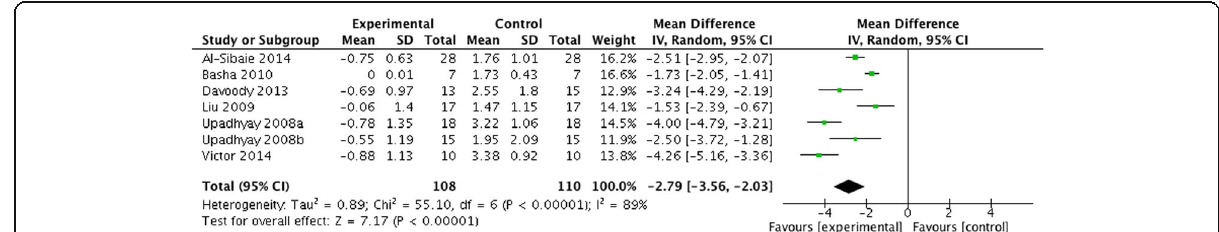
Fig. 3 Forest plot for anchorage loss in the horizontal